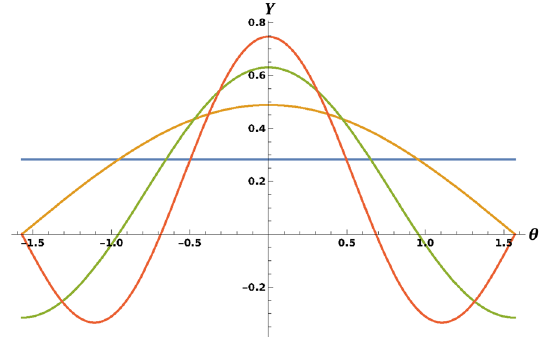
Figure 3. First four orders of the spherical harmonic functions Y 0 n ( θ ) as a function of θ (abscissa). The zero order is flat and successive orders are increasingly higher order in cosine terms. These are also related to the Legendre polynomials. When θ = π /2, at the surface of a flat piston transducer, the values of Y 0 n ( π /2 ) reduce to simple oscillations around ± 0.318 as a function of increasing n with a period of 4 n . The colors correspond to integer orders 0 (blue line), 1 (yellow line), 2 (green line), and 3 (orange line).